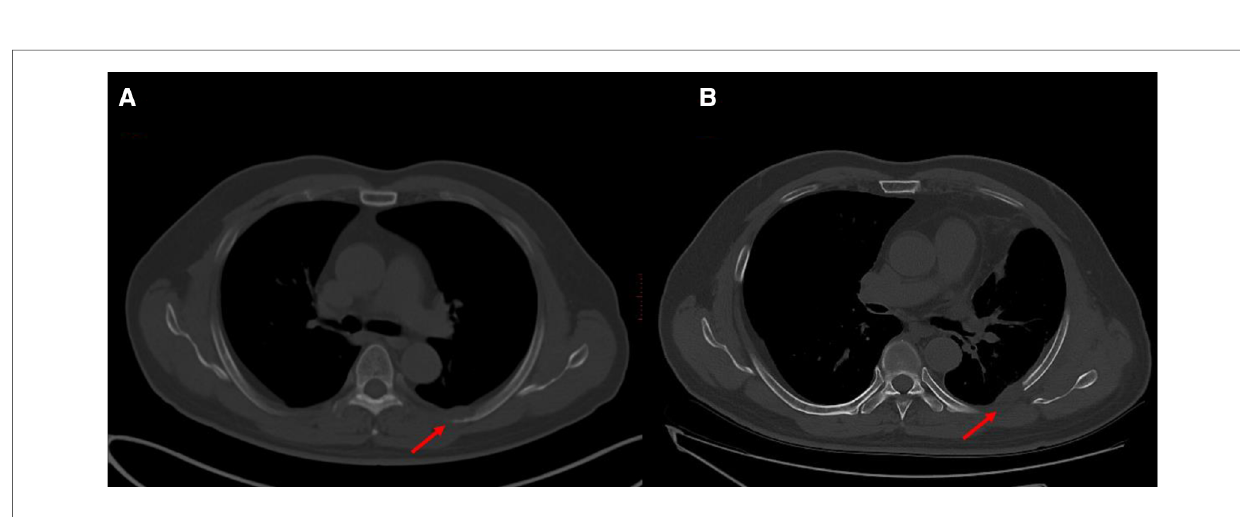
FIGURE 4 Images before and after surgery. ( A ) Prior to surgery, showing an osteolytic lesion in the left fi fth rib. ( B ) One month after surgery, part of the fi fth rib was excised with the